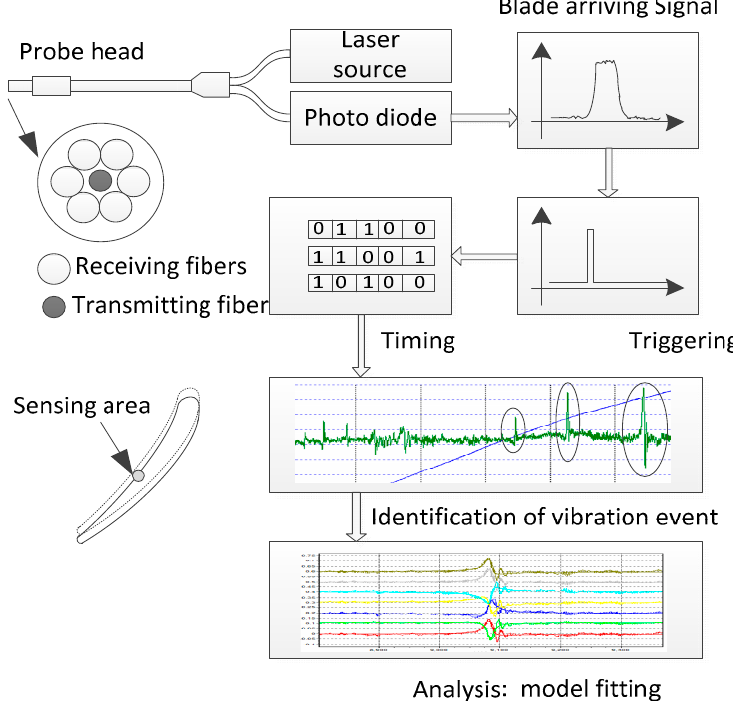
Figure 2. Signal processing of a BTT system.